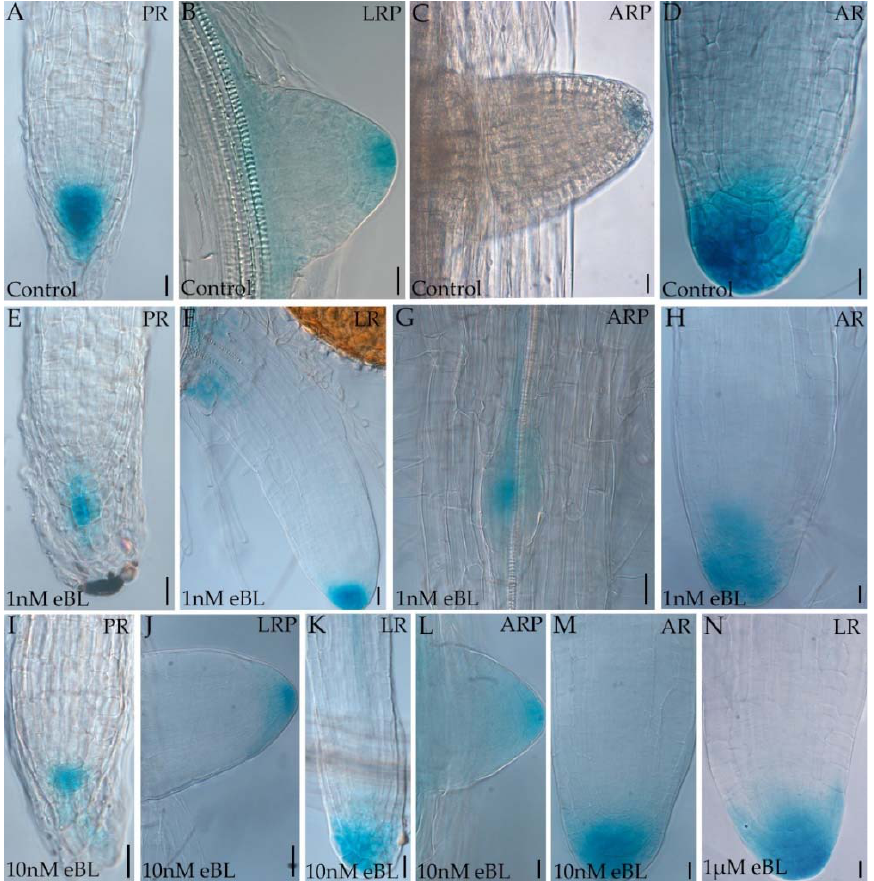
Figure 4. DR5::GUS expression in primary roots (PRs) ( A , E , I ), in adventitious roots (AR) primordia (ARPs, C , G , L ), in AR apices ( D , H , M ), in lateral roots (LR) primordia (LRP, B , J ) and in LRs ( F , K , N )